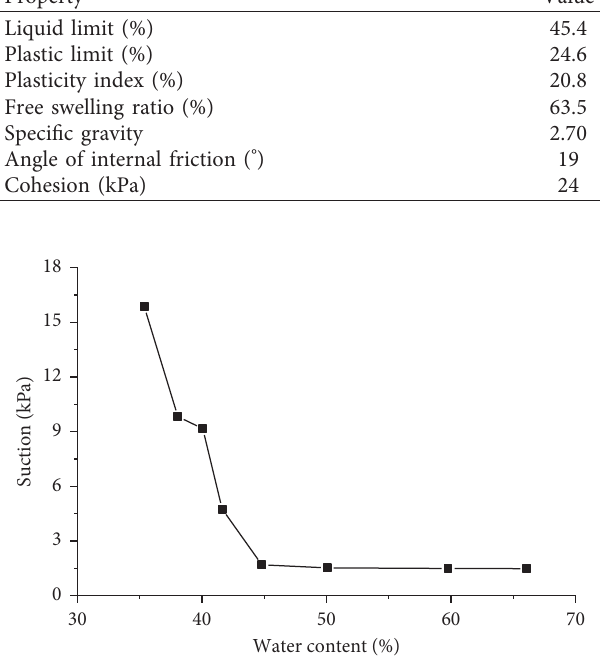
Figure 4: Relationship between matric suction and water content.